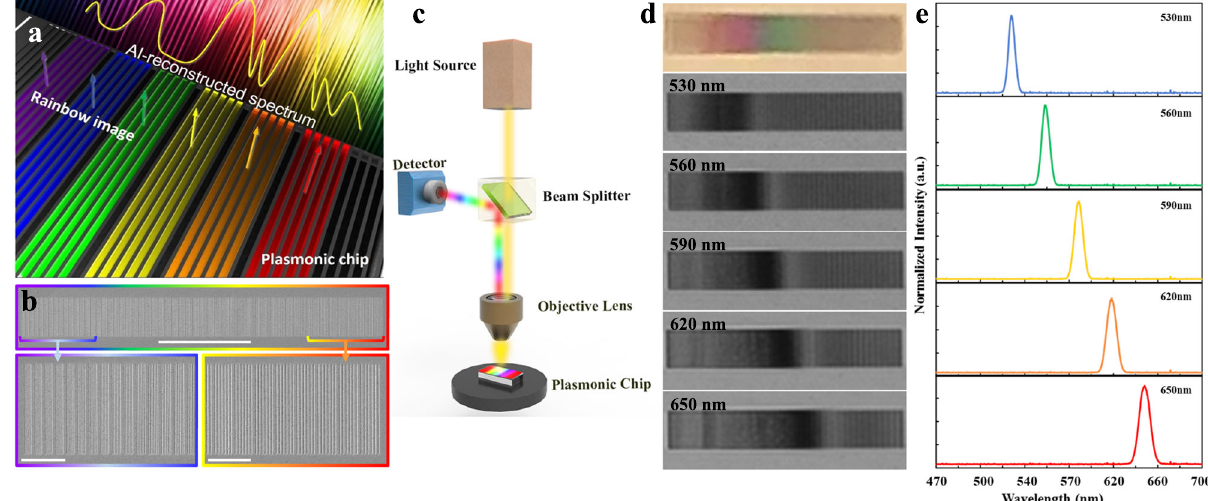
Fig.1|Plasmonicchirpedgratingsforon-chipspectrometer.a Illustrationofthe plasmonicchirpedgratingbeingusedasanon-chipspectrometer. b SEMimagesof the plasmonic grating fabricated on a thin Ag fi lm via focus-ion beam milling. The gratingiscomposedfromanassemblyofmultiple6-grooveunits.Theperiodofthe units increases from 244 to 764nm along the length of the chip. This allows for a spatial distribution of plasmon resonances, i.e., a “ rainbow trapping ” effect. The scale bar for the top image is 50 µ m; the scale bars for the bottom two images are